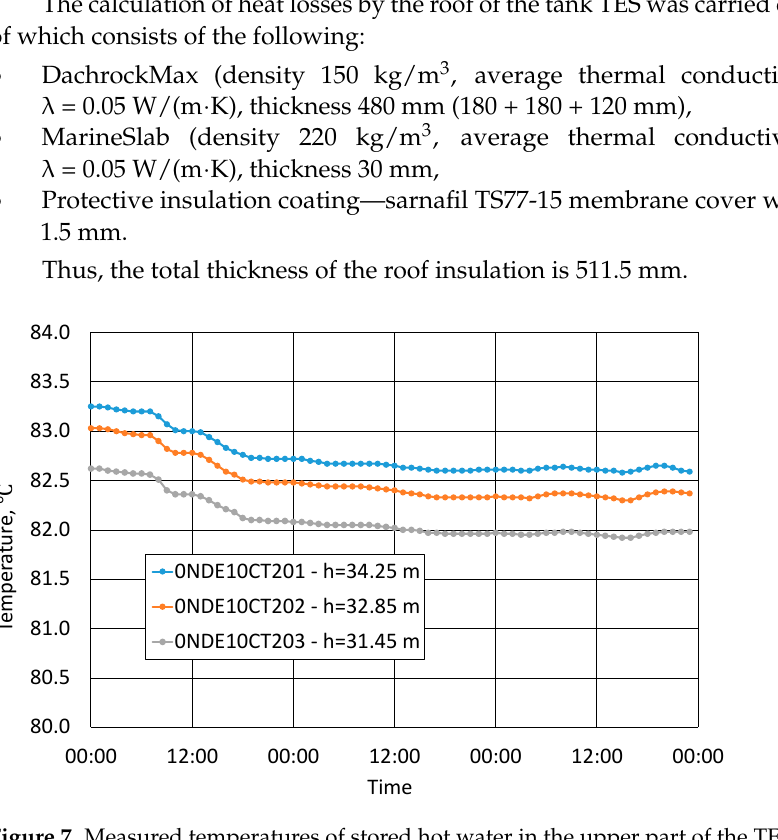
Figure 6. Data for 2.5 months’ operation (from 7 January 2021 to 13 February 2021 (a) and from 14 February 2021 to 18 March 2021 (b) ) of the TES with steam cushion system for CHP in Cracow.